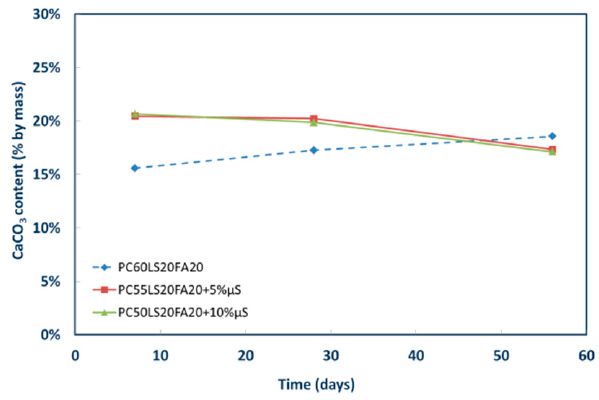
Figure 19. Ca(OH) 2 content μ S modified cementitious matrices based on PC60LS20FA20.